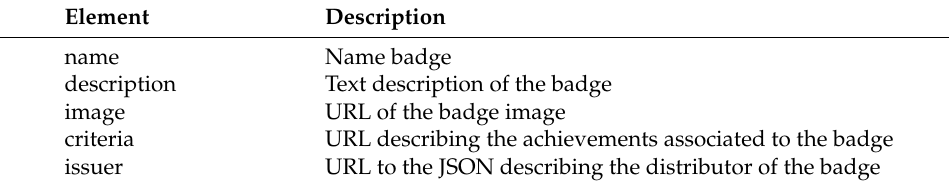
Table A2. JSON describing badge.